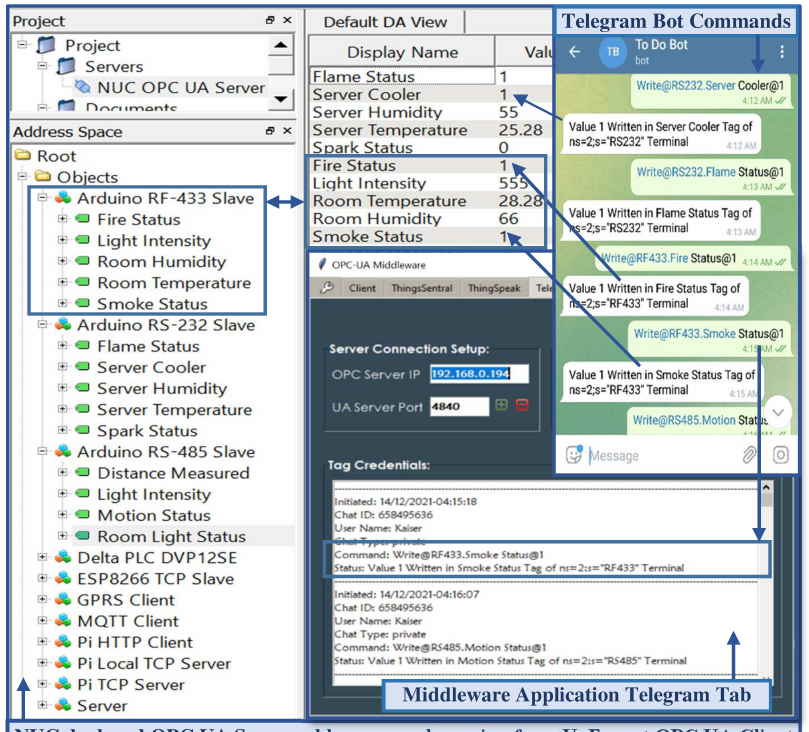
Figure 13. NUC deployed OPC UA server address space access from UaExpert and Telegram